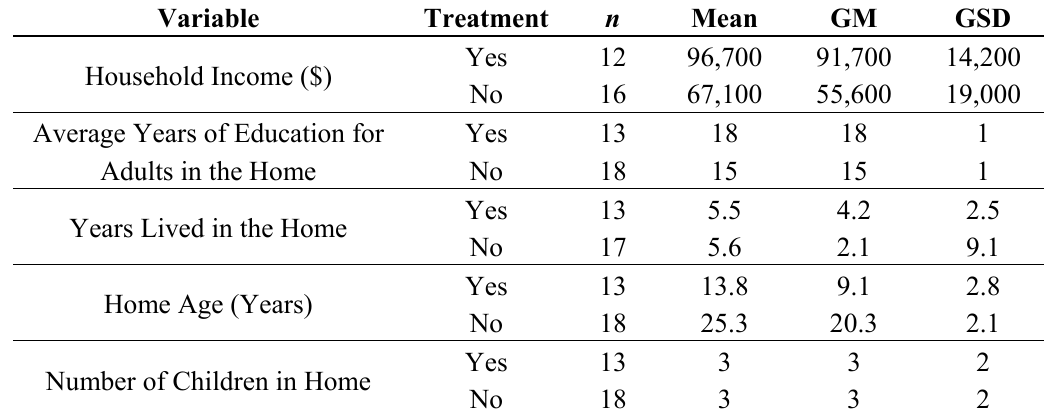
Table 2. Summary statistics for socio-demographic and home characteristics by home treatment. n : number of homes in treatment group, GM: geometric mean, and GSD: geometric standard deviation.